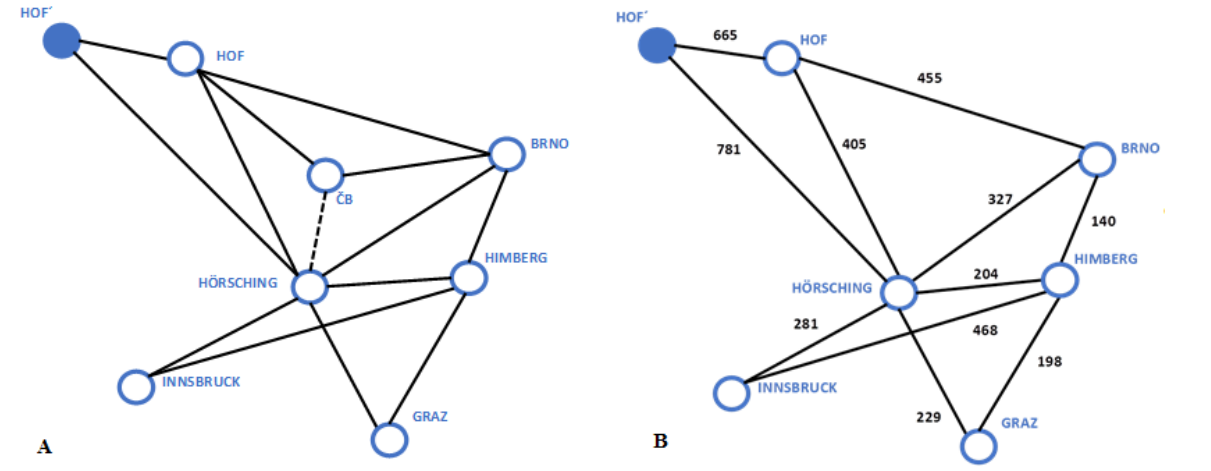
Figure 1: Selected (A) and modified (B) set for streamlining Table 1: Values of vertices of the selected graph set. Source: authors Customer state code